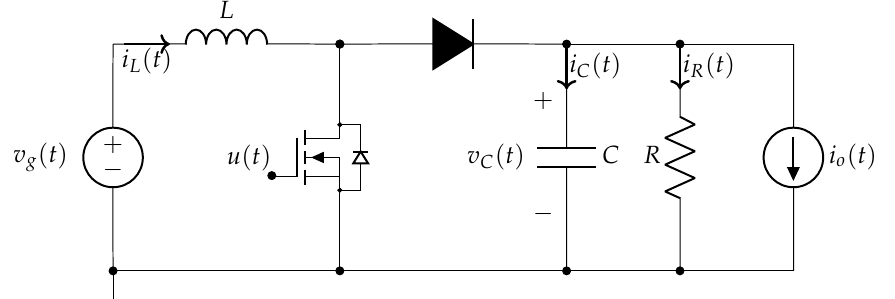
Figure 3. Schematic circuit of a boost